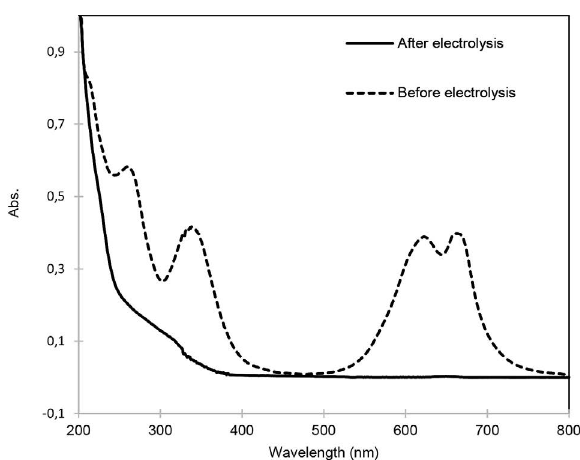
Figure 4. UV–Vis spectra of aqueous RB21 before and after electro- chemical treatment by using Co 47.5 C 47.5 -PVC composite electrode. ([RB21] o = 50 mg L –1 ; [NaCl] = 0.5 mol L –1 ; t = 45 min; E = 20 V; I = 0.93 A).